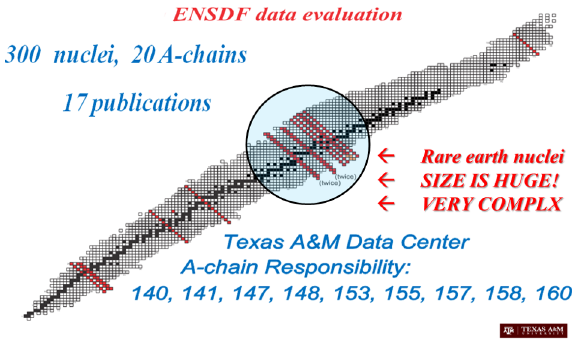
Figure 5. Texas A&M Data Center A-chain responsibility and the distribution on the nuclear